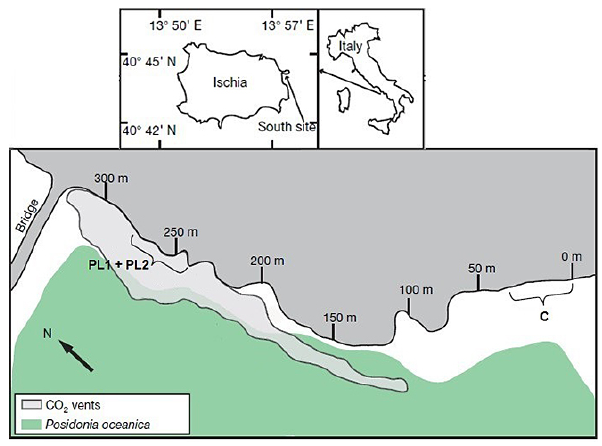
Figure 1. Study area, showing the low-pH sites (PL1 and PL2) and the control site